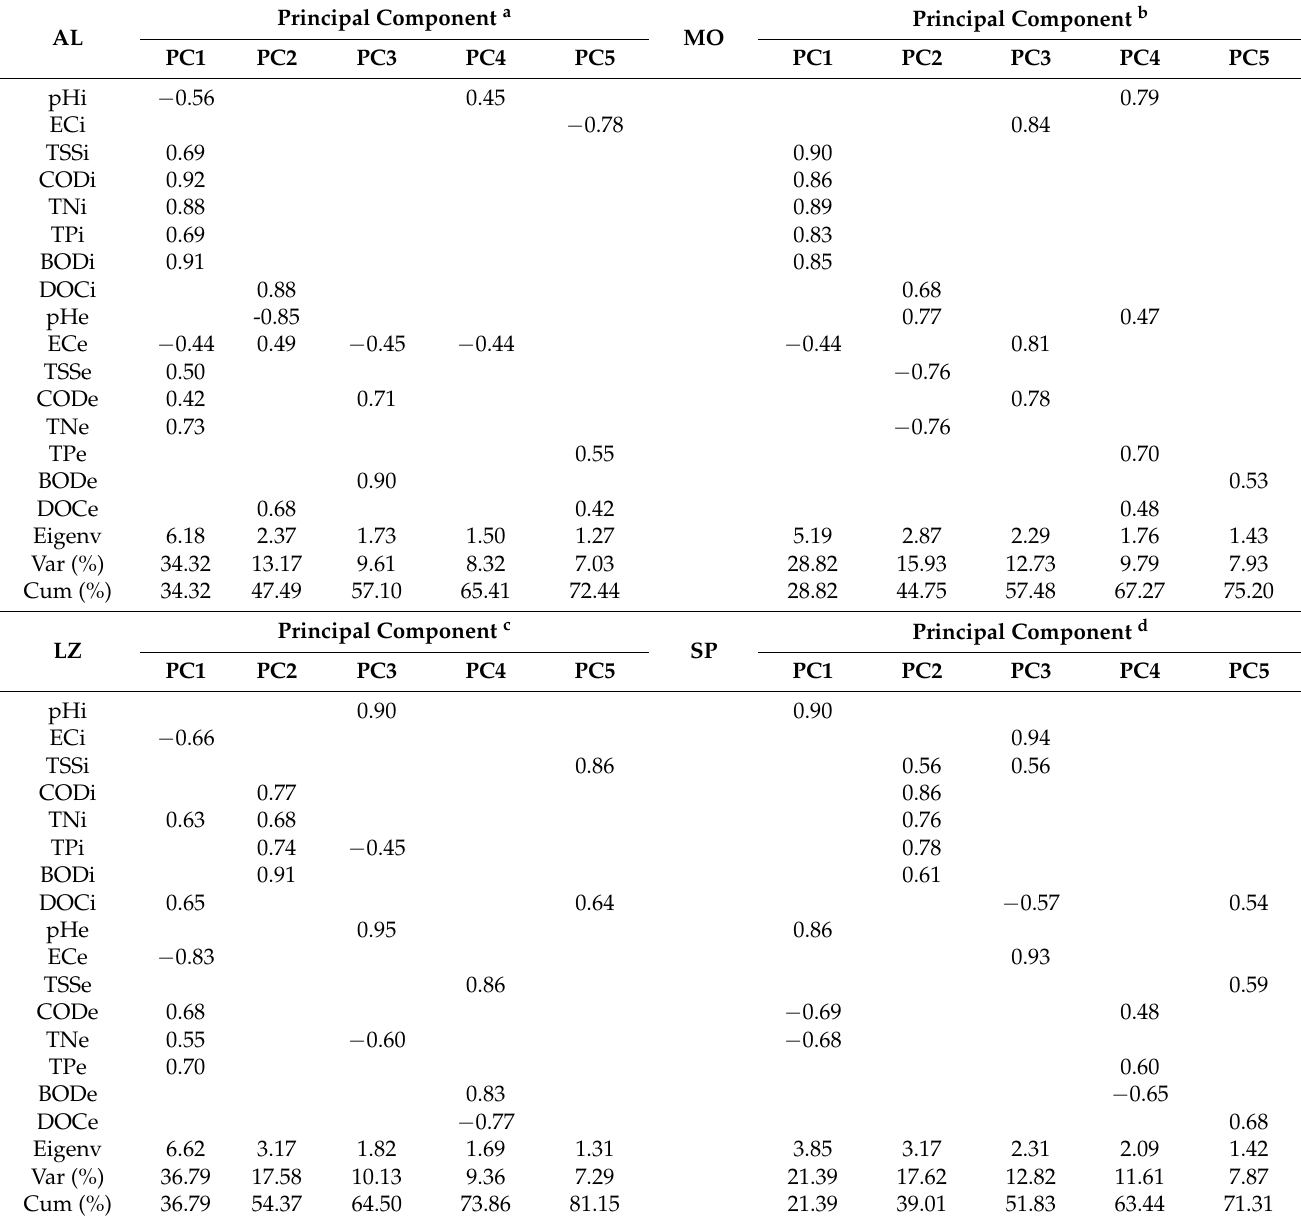
Table 3. Rotated component matrix with factor loadings